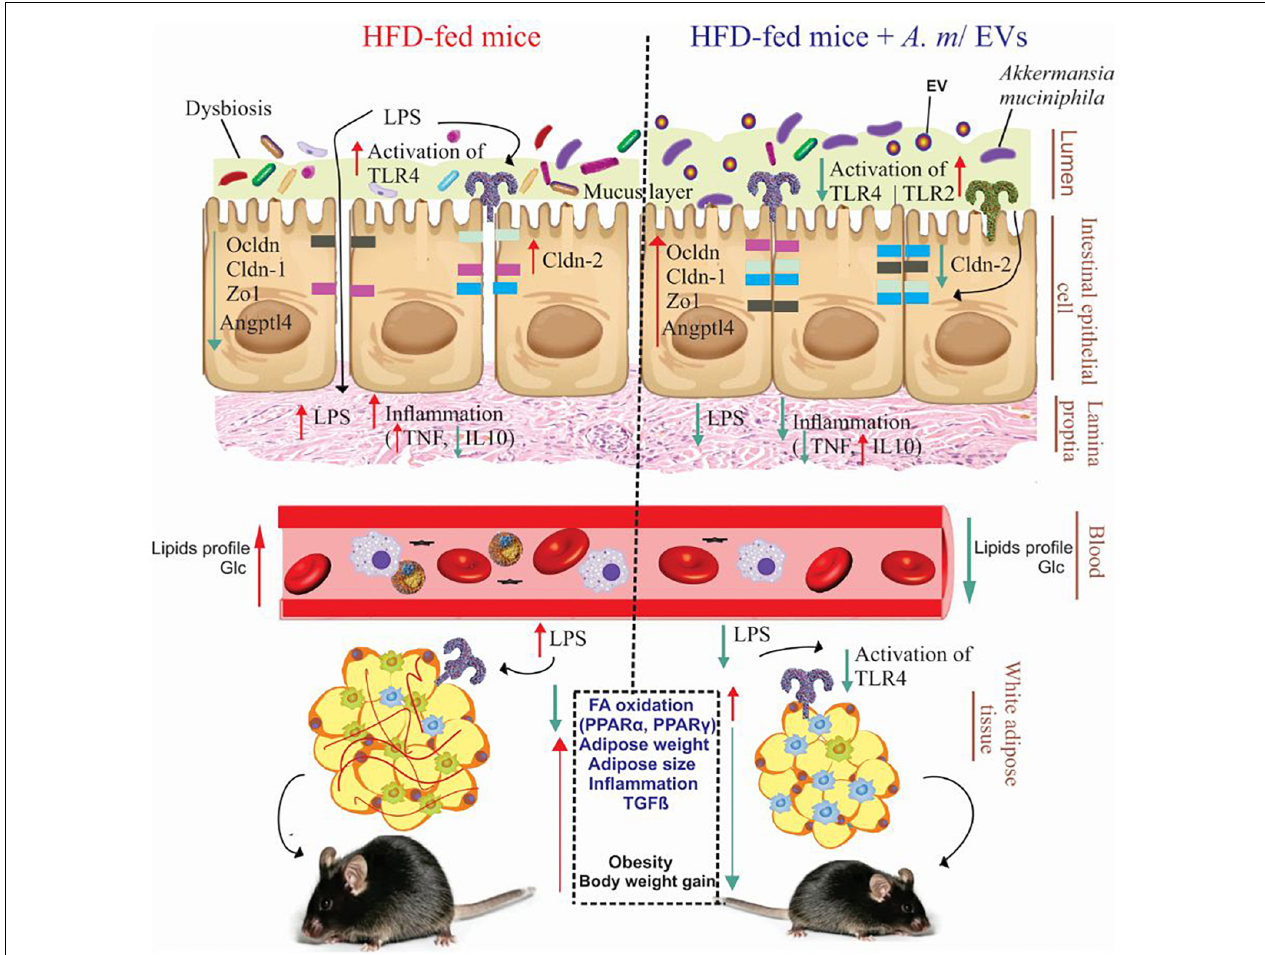
FIGURE 6 | Administration of A. muciniphila and its EVs improves the intestinal and metabolic homeostasis in obese mice. Obesity is associated with the disruption of the intestinal barrier integrity, inflammation, and fat mass gain (left). Oral administration of A. muciniphila or its EVs increase the expression of tight junction proteins and TLR-2 and reduce the expression of TLR-4 and pro-inflammatory cytokines in the colon of obese mice (right). Also, treatment with A. muciniphila and its EVs affects FA oxidation, local inflammation genes, and fat-mass loss in the EAT of obese mice. HFD, high-fat diet; EVs, extracellular vesicles; TLR , toll-like receptor; LPS, lipopolysaccharide; PPAR, peroxisome proliferator-activated receptor; Zo-1, zonula occludens-1; Ocldn, occludin; Cldn, claudin; Angptl4, angiopoietin-like 4; TNF- α , tumor necrosis factor- α ; IL-10, interleukin-10; TGF- β , transforming growth factor- β ; and Glc,